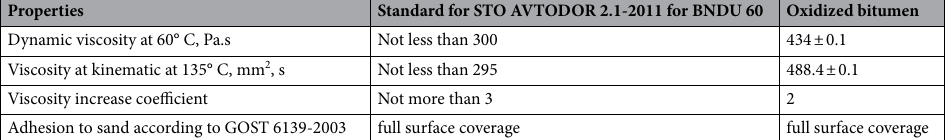
Properties Dynamic viscosity at 60° C, Pa.s